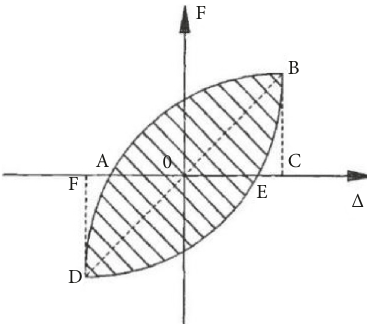
Figure 11: Calculation of the equivalent viscosity coefficient.